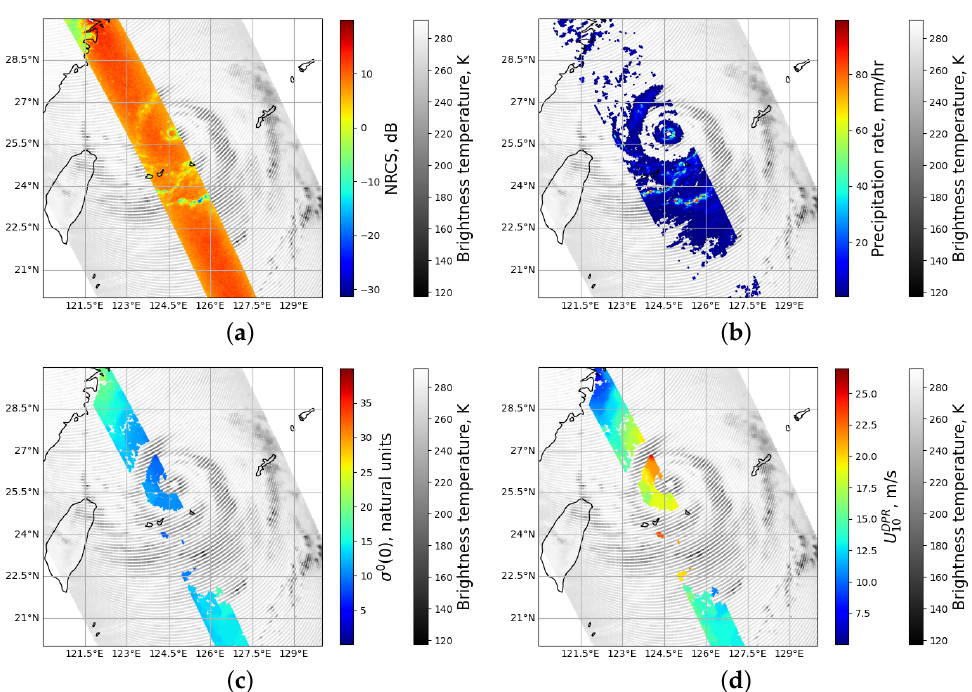
Figure 9. The DPR track over Typhoon Hinnamnor at 22:15 UTC on 3 September 2022. Raw data of the Ku-band radar over the image of brightness temperature from the GMI data at 89 GHz, V-polarization ( a ); rain rate ( b ); “nadir NRCS” ( c ); wind speed ( d ). Collocation of the DPR and ASCAT tracks was performed for the unnamed cyclone that was observed on 31 January 2015, at 14:30 UTC by DPR and at 12:30 by ASCAT. The maximum wind speed was not high in this cyclone. Wind speed in the DPR swath is presented in Figure 10a, and wind field from ASCAT data is presented in Figure 10b.